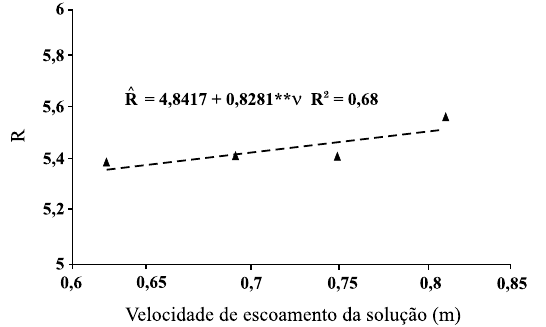
Figura 2. Fator de retardamento (R) de potássio estimado ( _ _ _ ) e médias dos valores experimentais ( ) observados num Latossolo Vermelho distrófico (LVd), em função da velocidade de escoamento da solução ( ). **: significativo a 1 % pelo teste